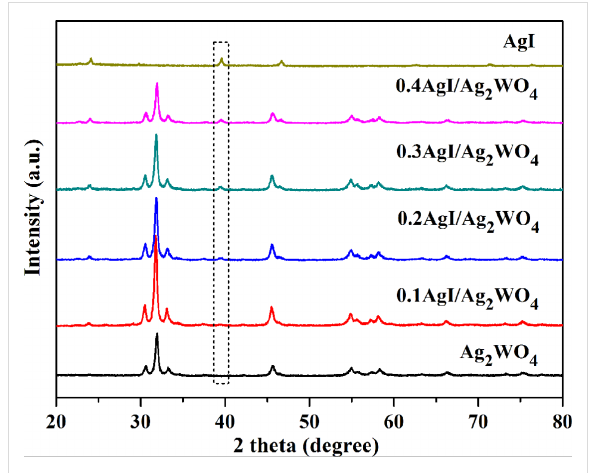
Figure 1: XRD patterns of Ag 2 WO 4 , AgI, 0.1AgI/Ag 2 WO 4 , 0.2AgI/Ag 2 WO 4 , 0.3AgI/Ag 2 WO 4 , and 0.4AgI/Ag 2 WO 4